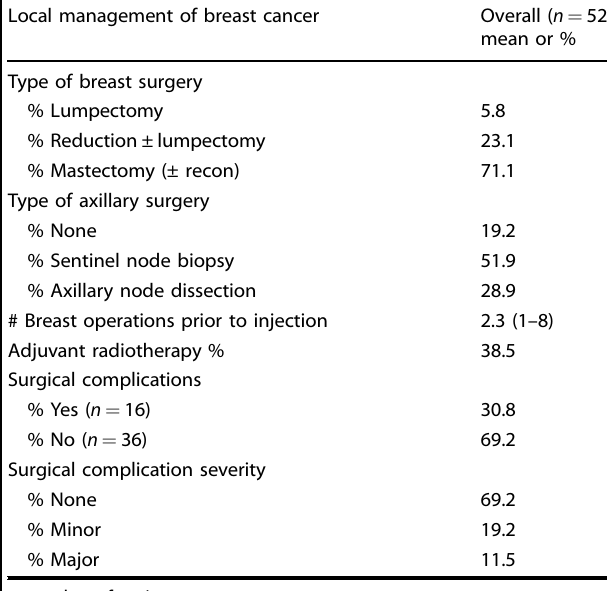
Table 2. Local management of breast cancer and